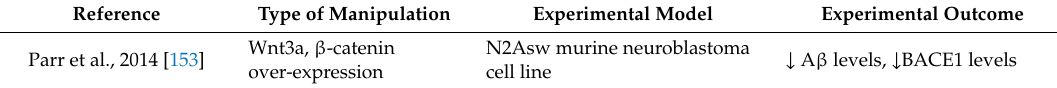
Table 1. Summary of Wnt targeting approaches in the published literature, where an increase of or restoration to normal signalling levels was attempted to treat neurological disorders (predominantly AD) in experimental models. ‘ ↑ ’ and ‘ ↓ ’ indicate increases or decreases in a measured experimental